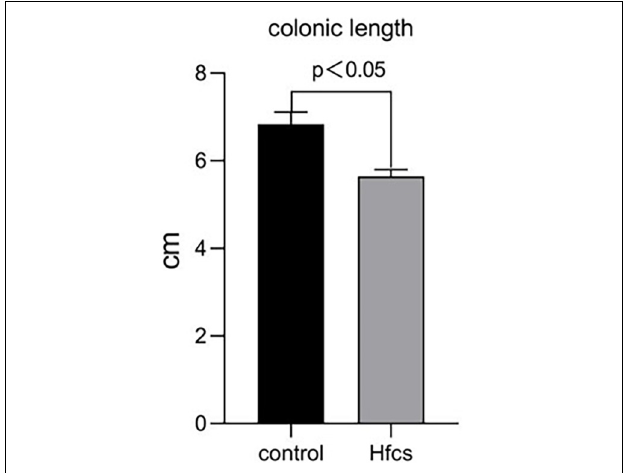
FIGURE 4 | Effect of HFCS on colonic length in mice. Data was expressed as mean ± SEM ( n = 8) and analyzed by one-way ANOVA